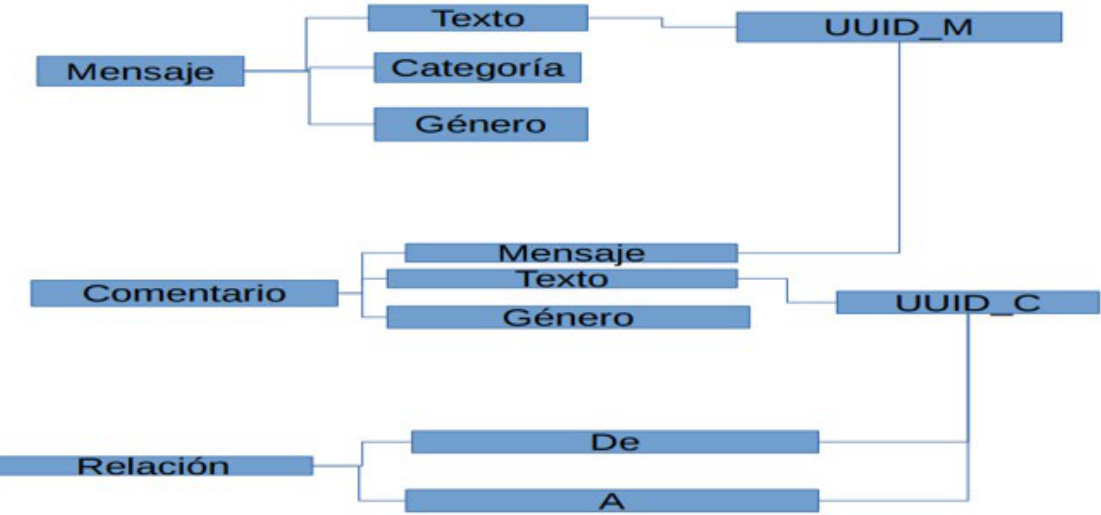
Figure 2. Relationship between message and interaction and its classification by